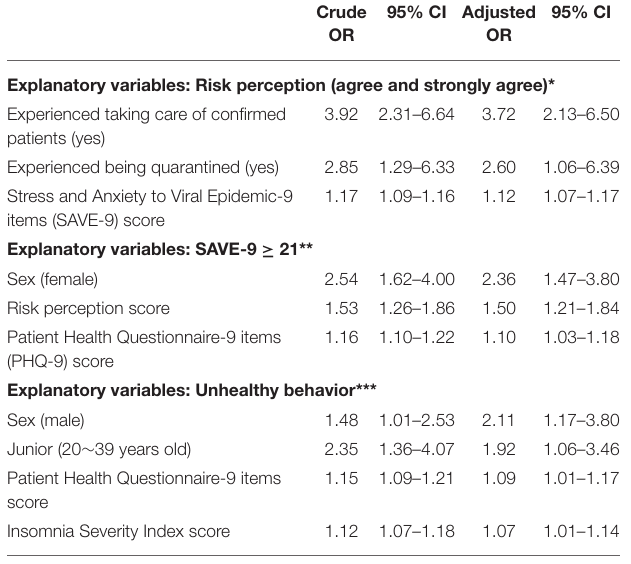
Crude 95% CI Adjusted 95% OR OR